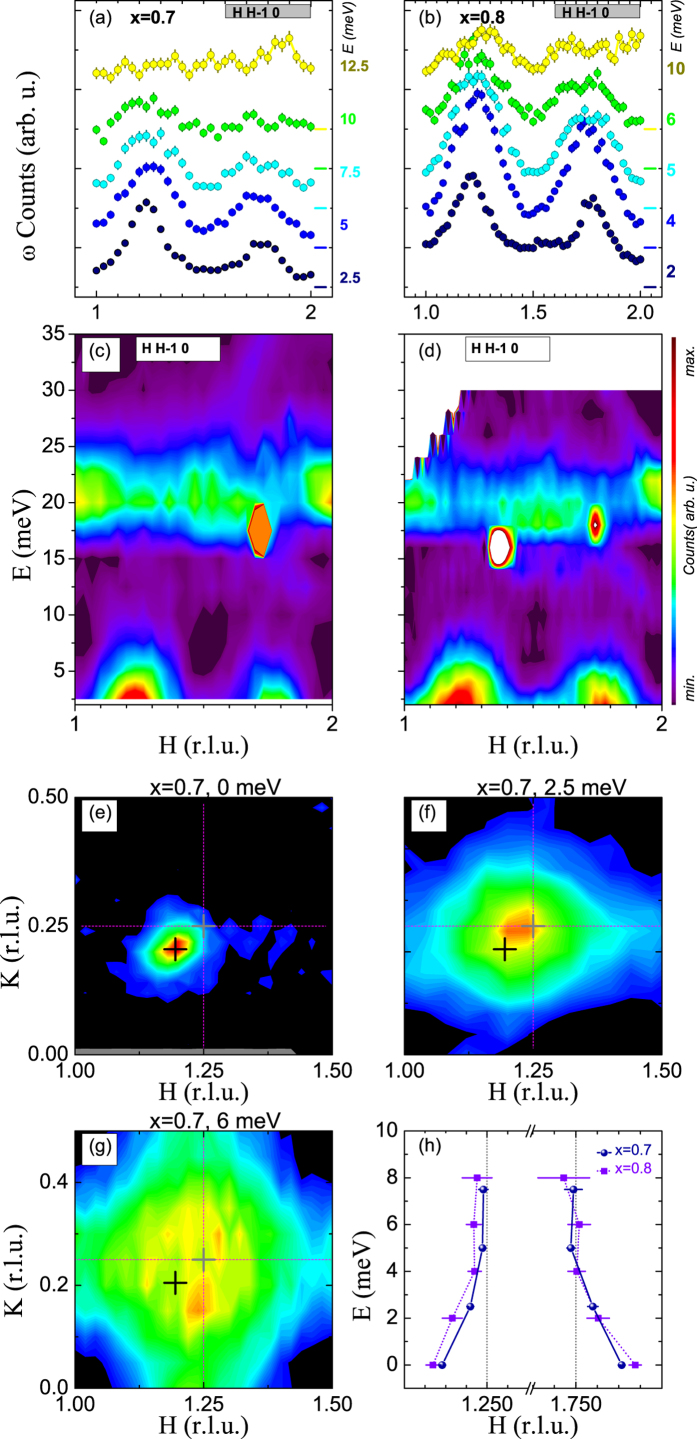
Magnetic excitation spectra of La1.3Sr0.7CoO4, La1.2Sr0.8CoO4.(a,b) Diagonal constant-E scans for different energies. (c,d) Neutron scattering intensities as a function of energy and momentum transfer in the color contour plots. (e–g) Magnetic correlations of La1.3Sr0.7CoO4 in the HK0 plane of the reciprocal space for energy transfers of 0, 2.5, and 6 meV. The black and grey crosses indicate the positions of the incommensurate magnetic satellites in La1.3Sr0.7CoO4 and in an ideal checkerboard charge-ordered La1.5Sr0.5CoO4 sample, respectively. (h) The center of the magnetic excitations in La1.3Sr0.7CoO4 and La1.2Sr0.8CoO4 as a function of energy.